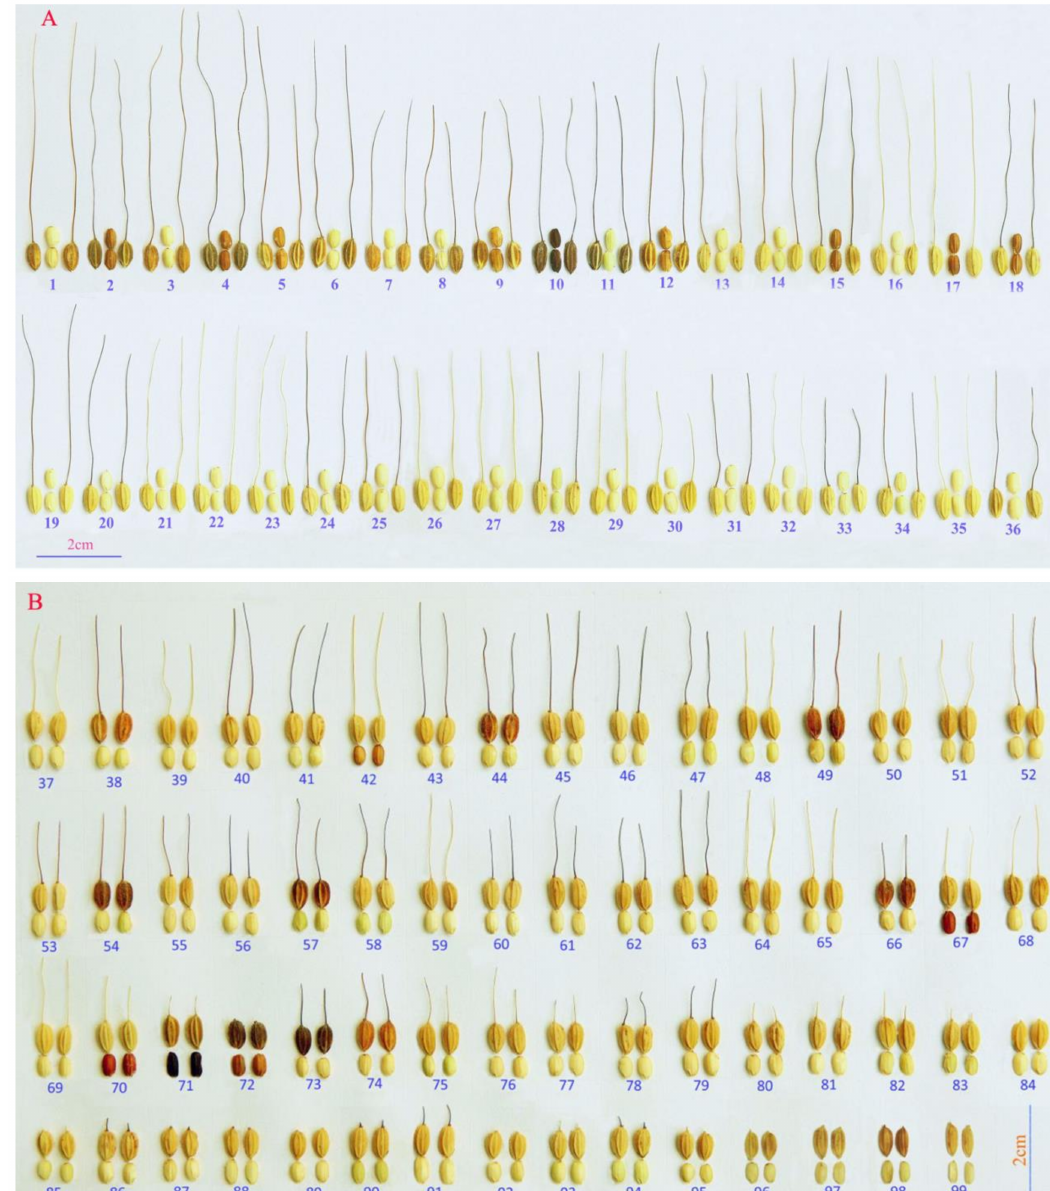
Figure 2. ( A ) The diversity of morphological traits of panicles in Kam fragrant glutinous rice. ( B ) The diversity of morpho- logical traits of spikelets and seeds in Kam fragrant glutinous rice. No. 96–99 are the control varieties, in which 97 and 98 are glutinous japonica , 96 and 99 are non-glutinous indica